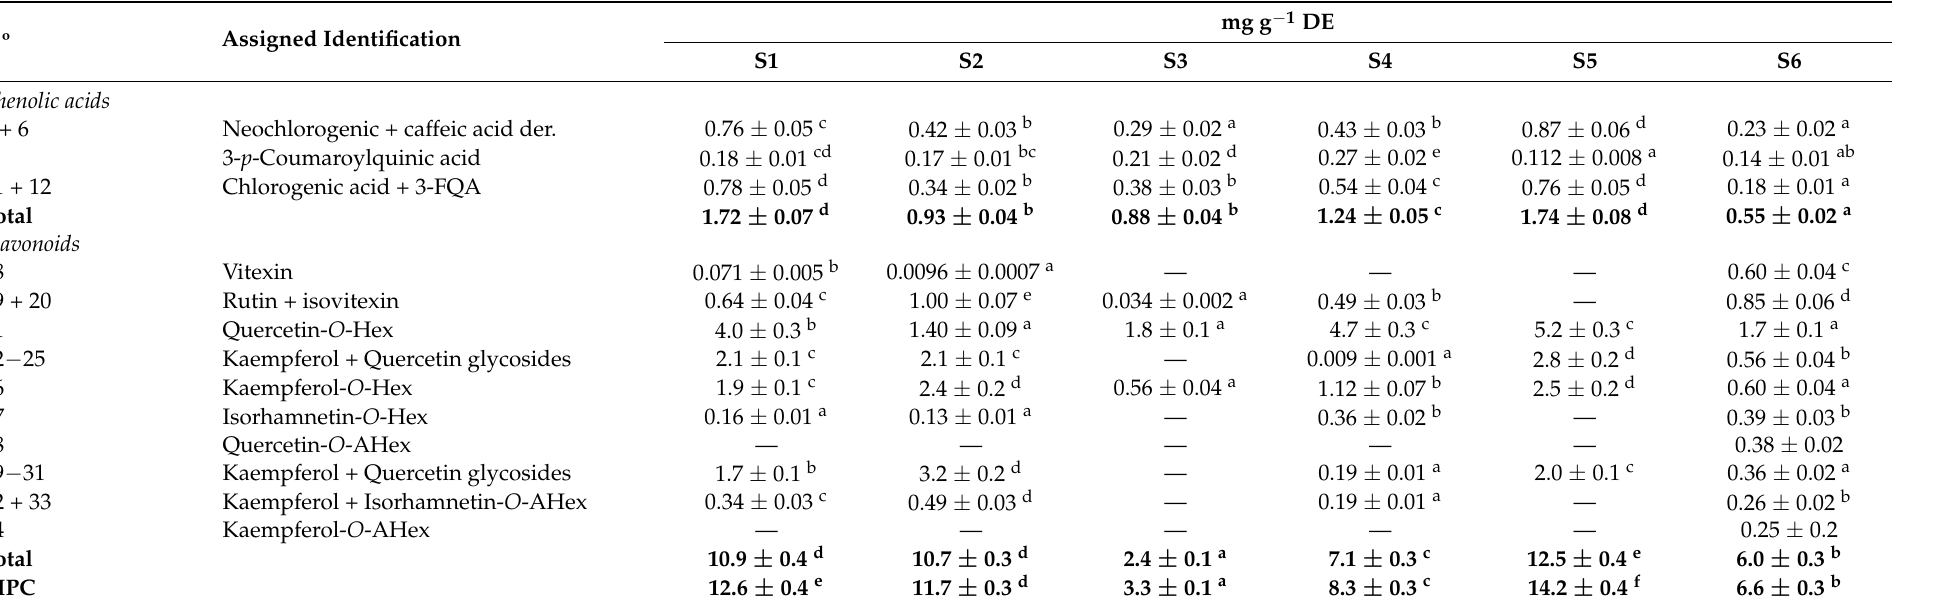
Values are reported as mean ± SD of three parallel experiments. Bold values represent the sum of each type of components. Means in the same line not sharing the same letter are significantly different at p < 0.05 probability level. Hex = hexoside (usually glucoside, but also galactoside); der. = derivative; FQA = feruloylquinic acid; AHex =